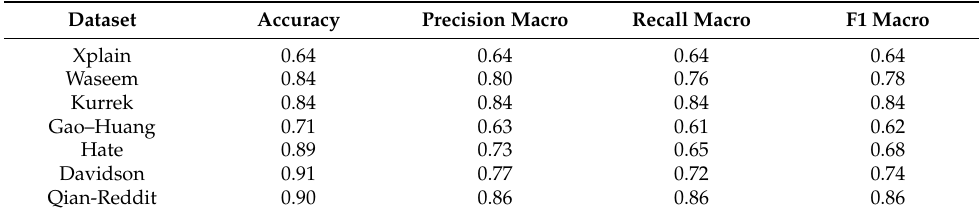
Table A8. Scores obtained on the benchmark Datasets using one-way interconnected recurrent layers. The embeddings were made with the help of GloVe vectors.